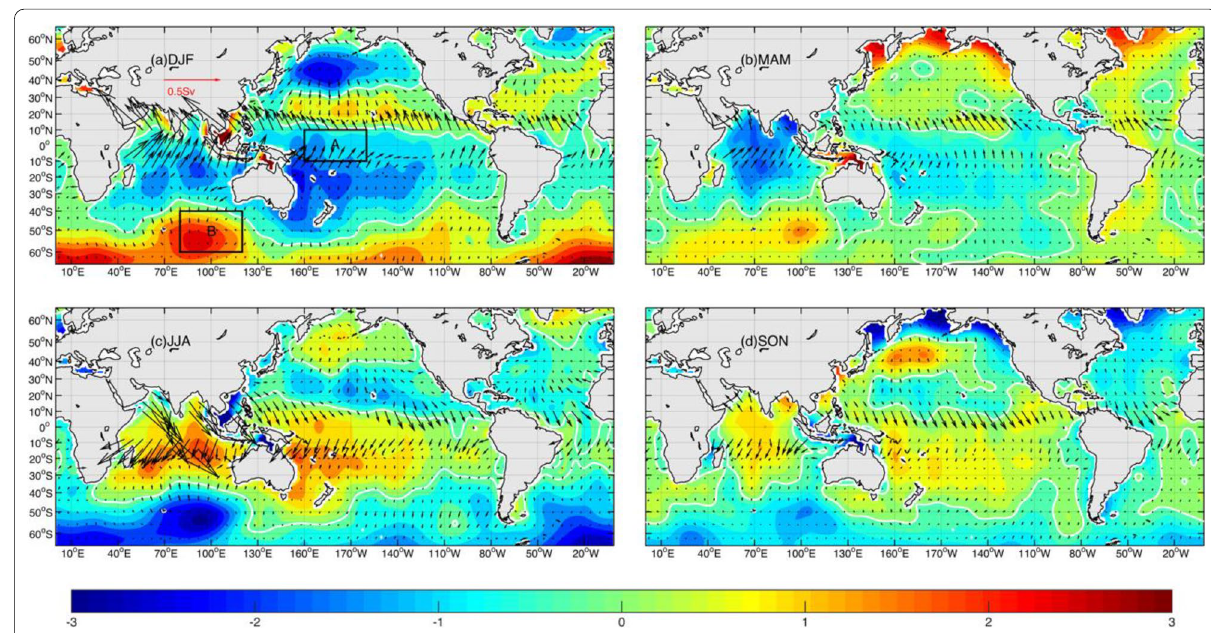
Fig. 1 Ocean bottom pressure (color maps, in cm) derived from GRACE data and Ekman transport anomalies (vectors, in Sv) in the world oceans for four seasons. The anomalies are relative to their annual